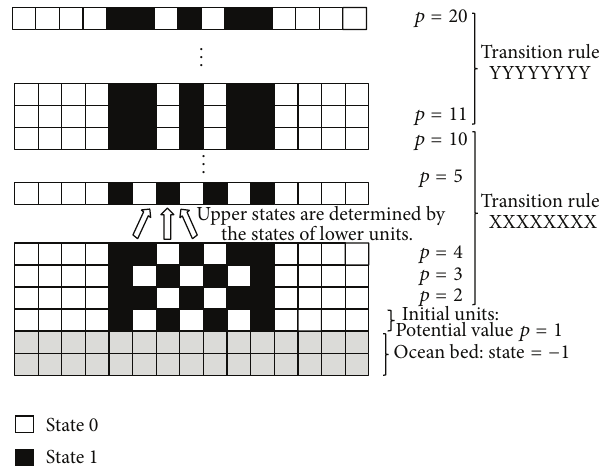
Figure 5: Construction model of underwater space. A two-dimen- sional square cell grid is considered in the vertical direction. Each cell has two attributes: one is the state (ocean bed ( − 1), marine water (0), and structural module (1)) and the other is the potential value 𝑝 that expresses the hierarchy from the bottom of the seabed. Under these conditions, the structural modules are piled up according to the algorithm of transition rule.